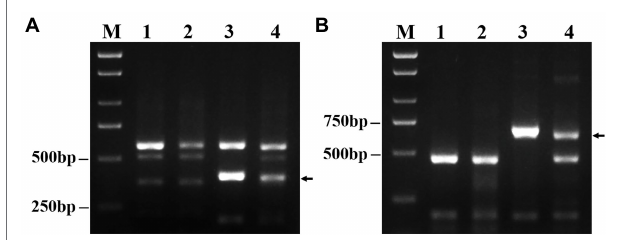
FIGURE 3 | Amplification patterns of wheat PLUG markers. (A) TNAC1782- TaqI , (B) TNAC1845 - TaqI . M: Marker (2000 bp); 1: CS; 2: CS ph2b ; 3: P. huashanica ; 4: DT23 (wheat- P. huashanica ditelosomic addition line). Arrows indicate the diagnostic amplification products for Ns